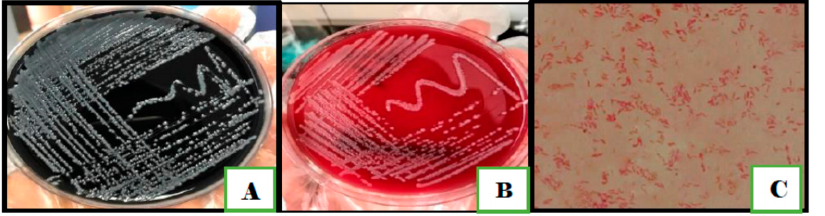
Figure 1. Colony morphology of Campylobacter species on ( A ) on mCCDA agar; ( B ) Columbia blood agar; ( C ) Gram staining of C. jejuni shows Gram negative spiral rods with seagull-wing shape. Table 1. Biochemical tests to differentiate between Campylobacter jejuni and Campylobacter coli